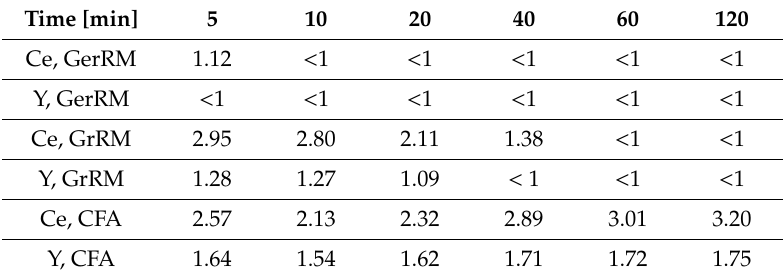
Figure 14. Concentration of yttrium and cerium in time. Table 10. Yttrium and cerium in precipitation experiment [mg/L].